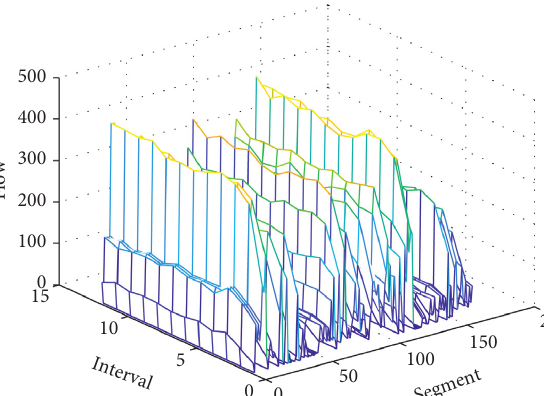
Figure 8: The averaged flow without control.